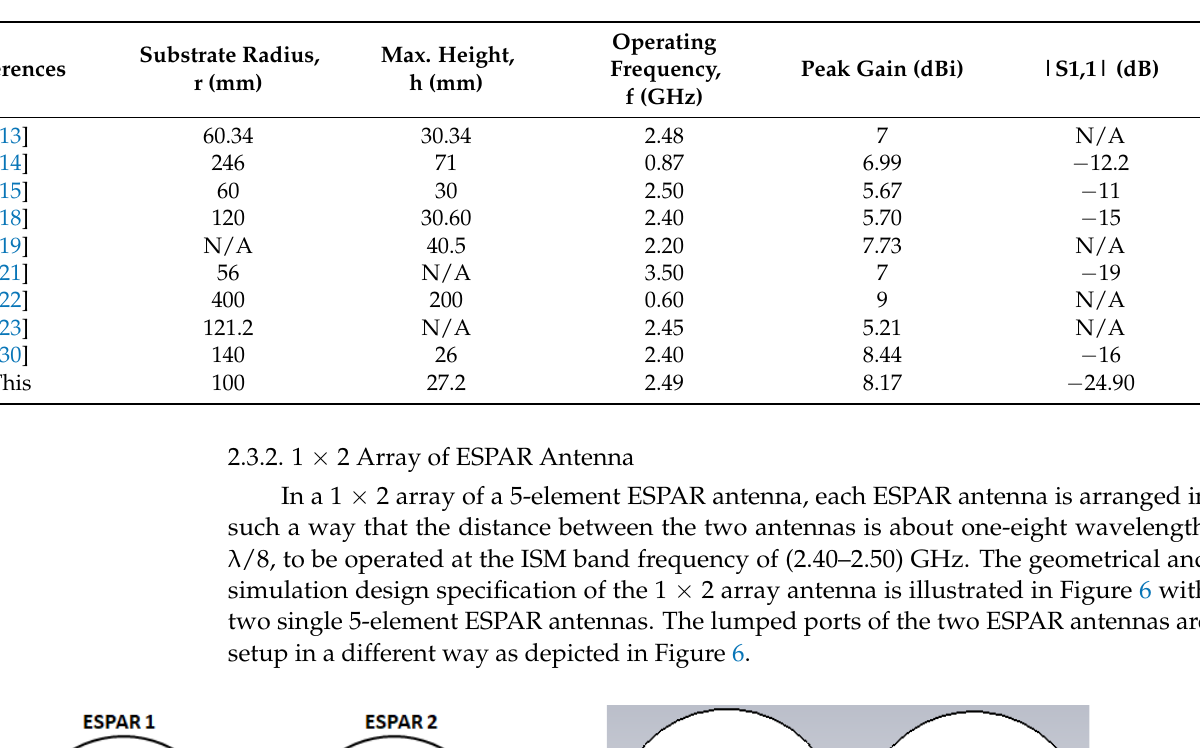
Table 3. Comparative analysis of the single ESPAR antenna. Substrate Radius, References